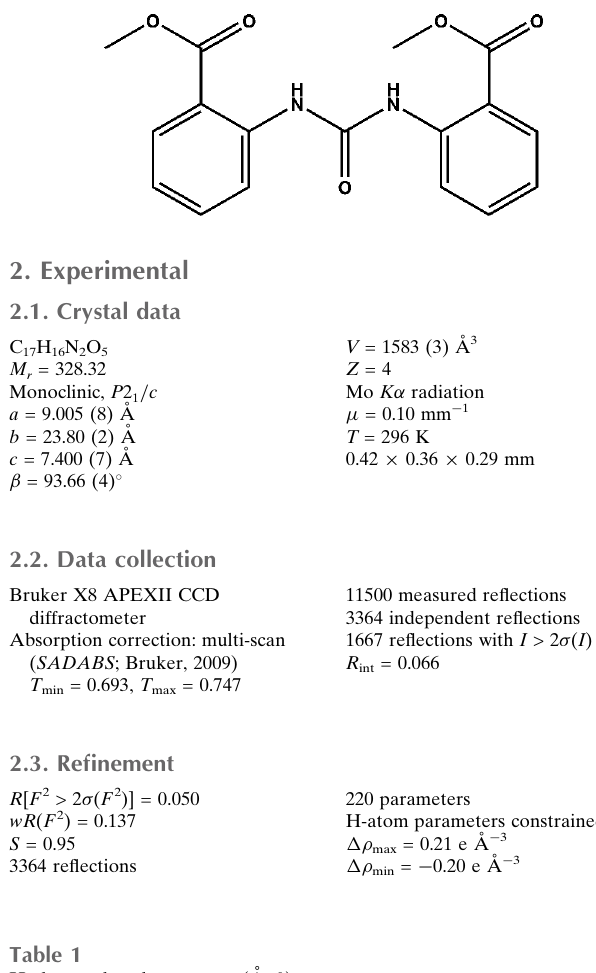
Hydrogen-bond geometry (A˚ , (cid:2)